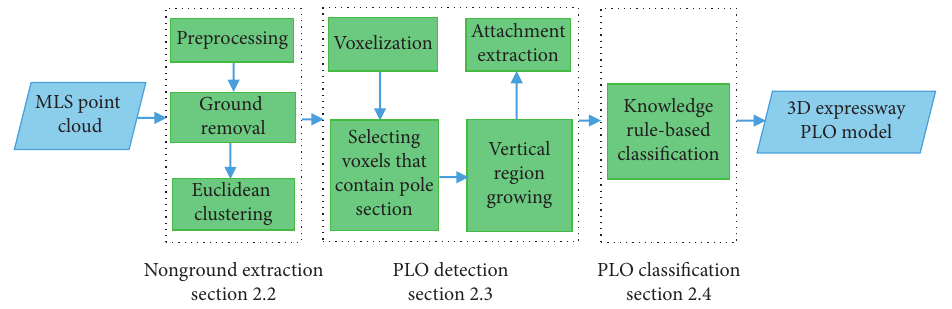
Figure 1: Workflow for PLO detection and